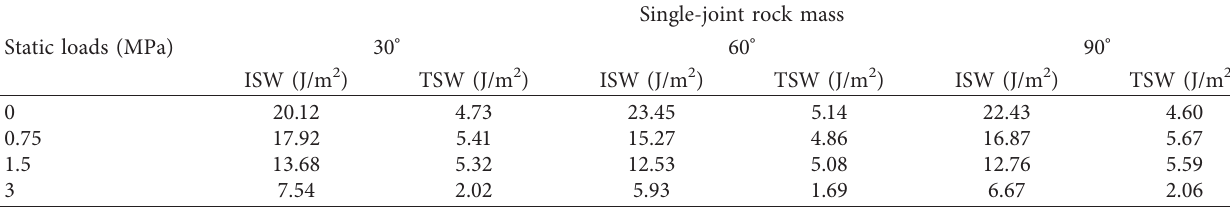
Table 4: Energy intensities of incident and transmitted stress wave in single-joint rock mass under different equal biaxial static loads. Static loads (MPa)